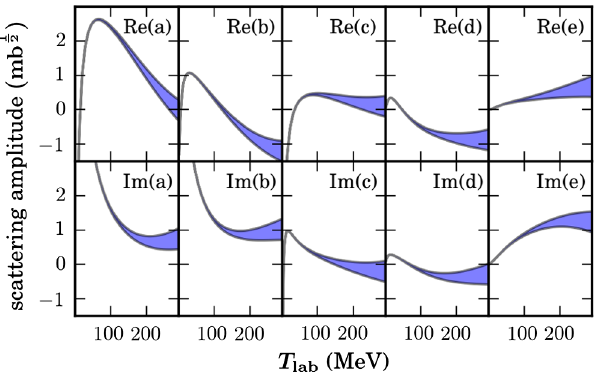
45 ° scattering angle cm ¼